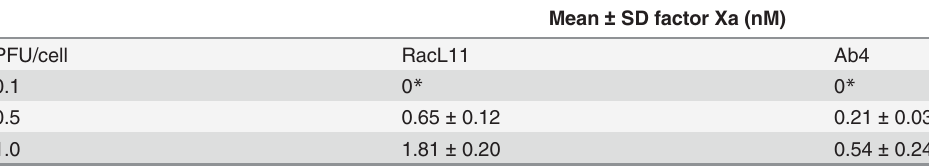
Table 2. Equid herpesvirus type 1 generates factor Xa (FXa) in a dose-dependent manner.